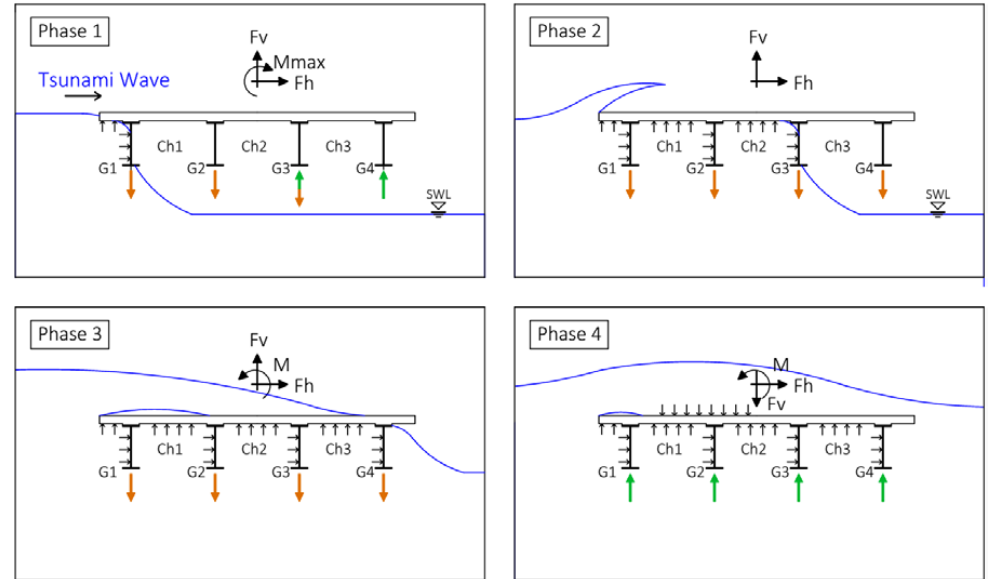
Figure 21. Tsunami inundation mechanism of a bridge.